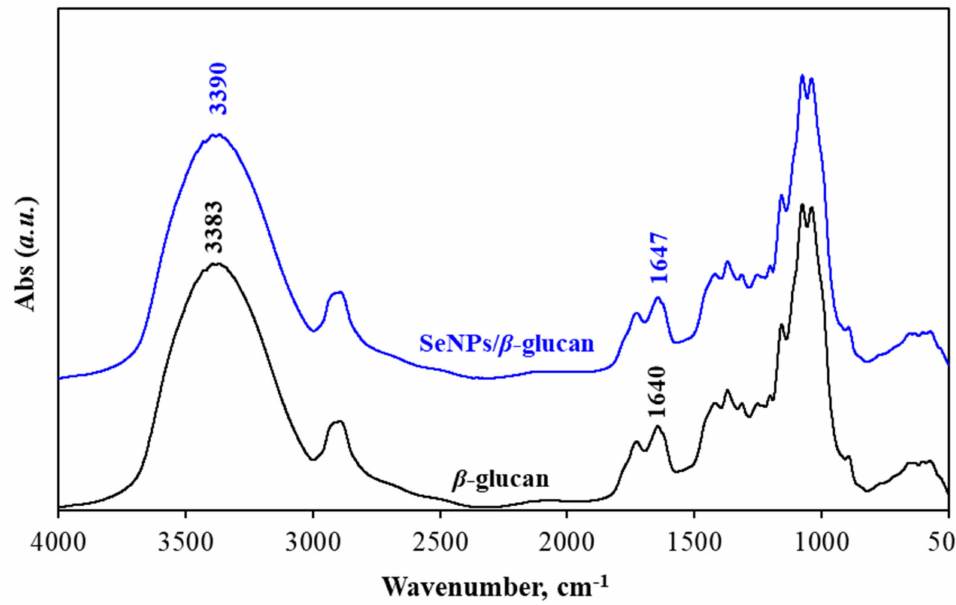
Figure 6. FTIR spectra of β -glucan and SeNPs/ β -glucan synthesized by gamma irradiation at dose of 8 kGy and dose rate of 10 kG h − 1 .